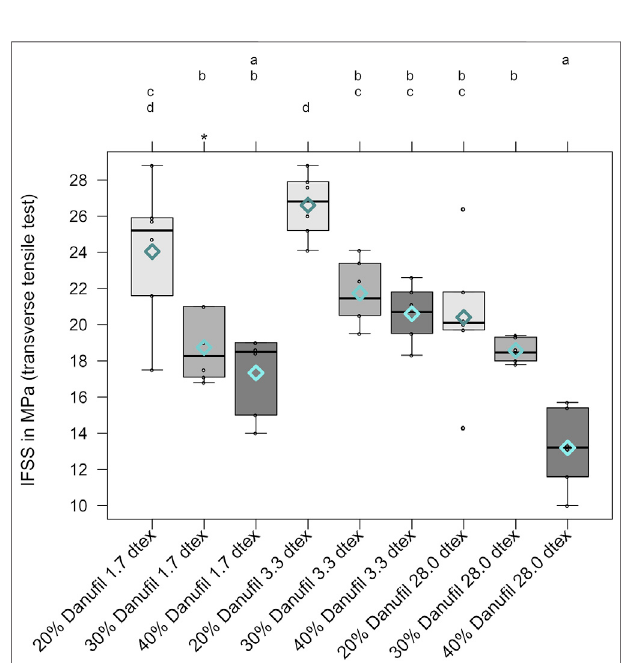
FIGURE 9 | Interfacial shear strength (IFSS) determined by a transverse tensile test. Results are shown as Box-Whisker-Plots with the mean values as rhombuses. Different letters indicate signi fi cant differences. A * marks results which do not follow a normal distribution.